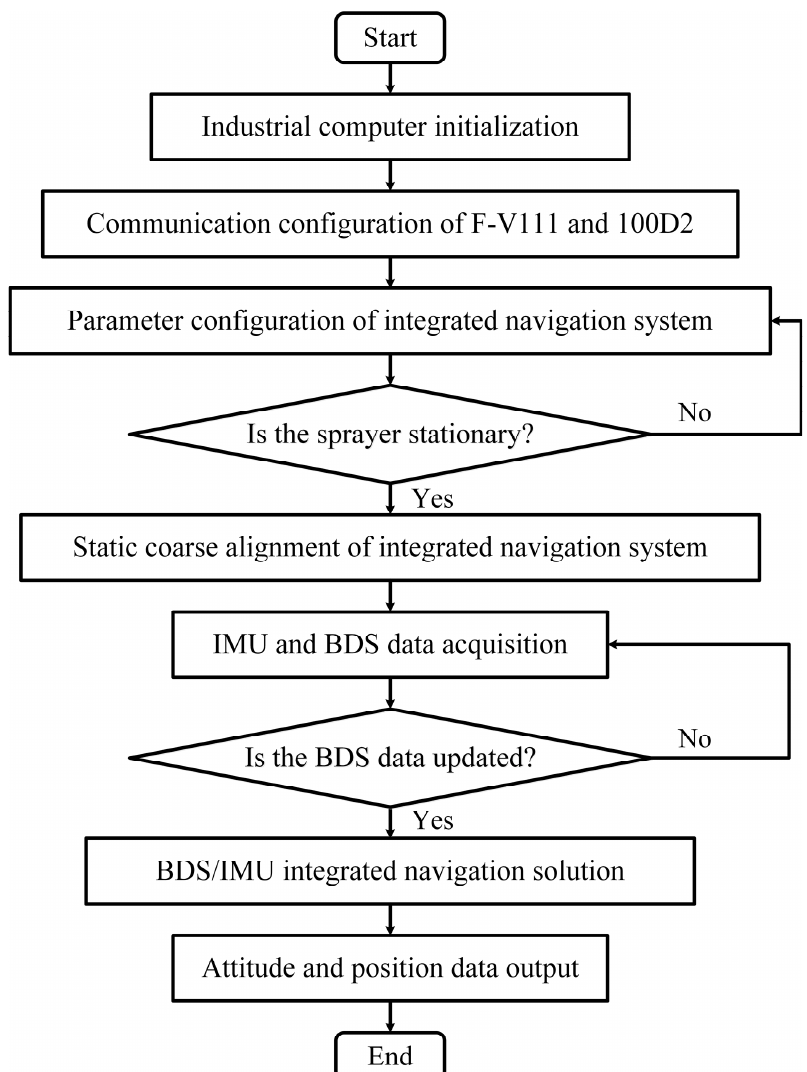
Figure 5. The flow chart of the integrated navigation program.